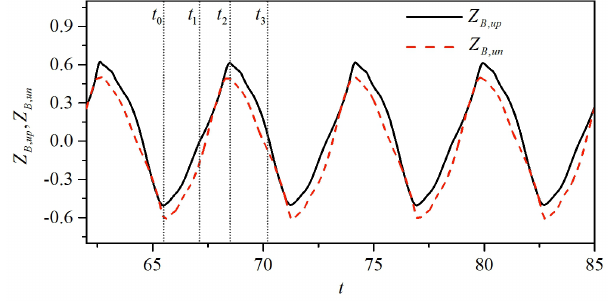
Figure 9. Time evolutions of the transverse displacements of points B 1 and B 2 at G z = 0.1.